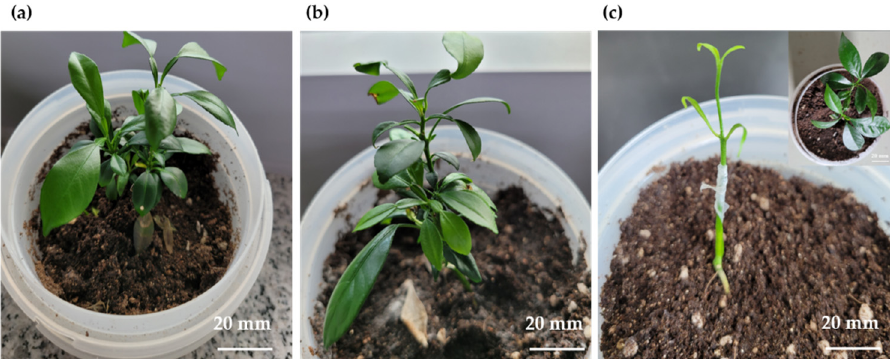
Figure 5. Morphological characteristics of plants produced using anther culture. Plants obtained through anther culture after approximately 2 months of in vivo grafting. ( a ), hetero-diploid plant (control); ( b , c ), putative haploid-derived regenerated plants.